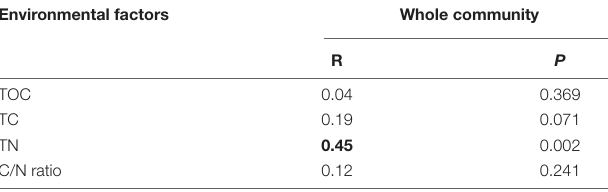
TABLE 2 | Correlation relationships between the community compositional dissimilarity and the measured environmental factors by Mantel test. Environmental factors